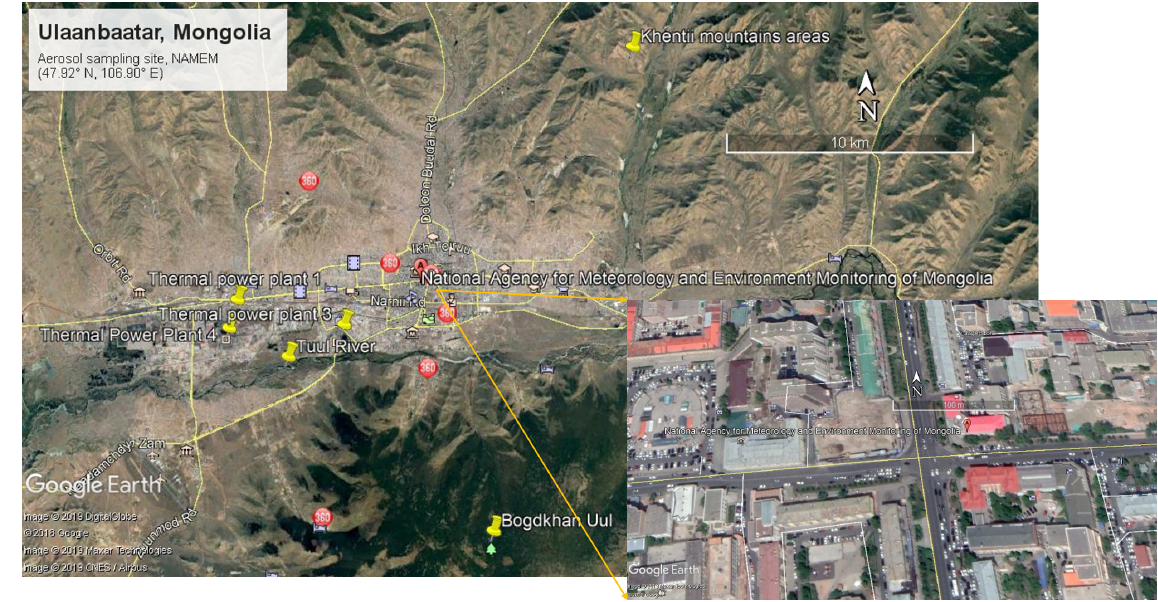
Figure 1. Sampling site in Ulaanbaatar, Mongolia (https://awww.google.com/earth/versions/#earth-pro, last access: 11 July 2019, © Google